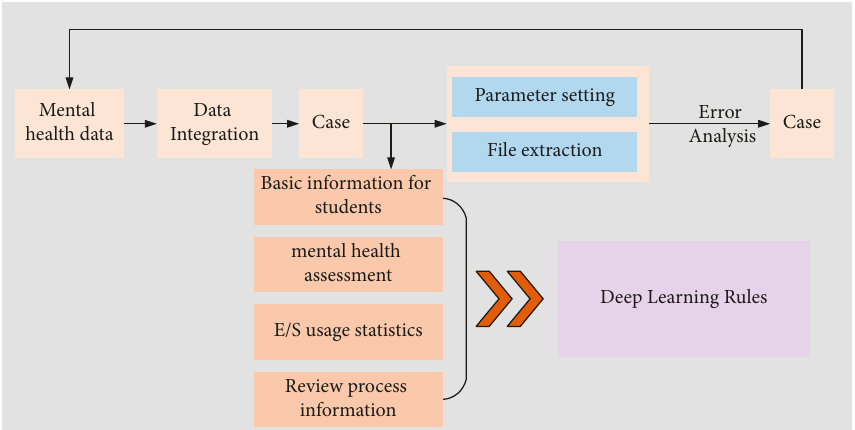
Figure 2: The evaluation and analysis model construction process of deep learning theory on college students’ mental health status.